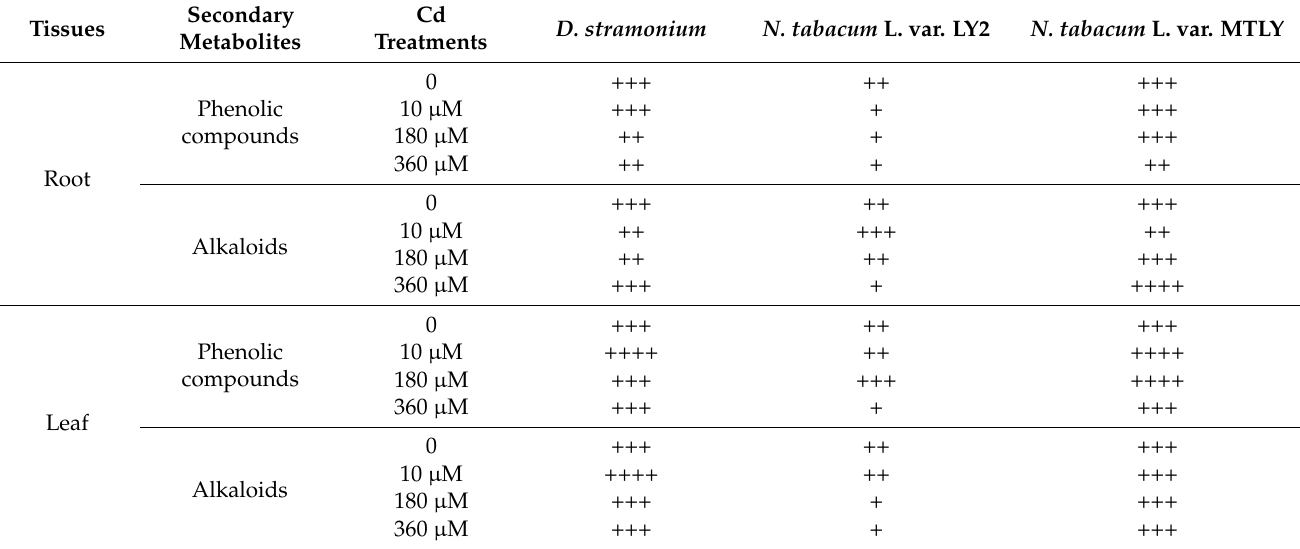
Table 1. A preliminary evaluation for the accumulation of main metabolites in seedling tissues. N. tabacum L. var. LY2 N. tabacum L. var.